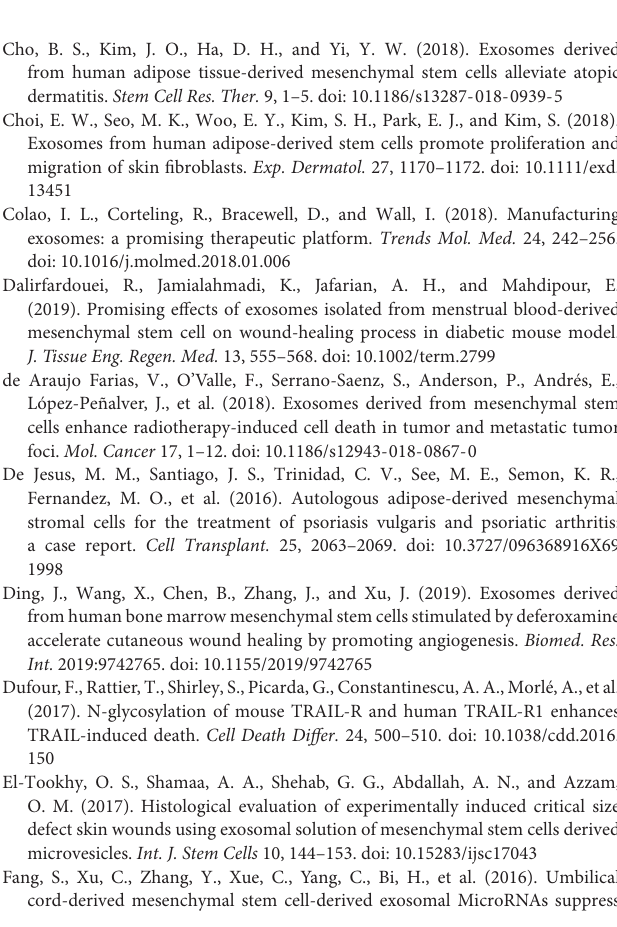
Supplementary Table 1 | In vitro studies of MSC exosomes in wound healing. Supplementary Table 2 | In vivo studies of MSC exosomes in wound healing. Supplementary Table 3 | In vivo studies of MSC exosomes in other skin